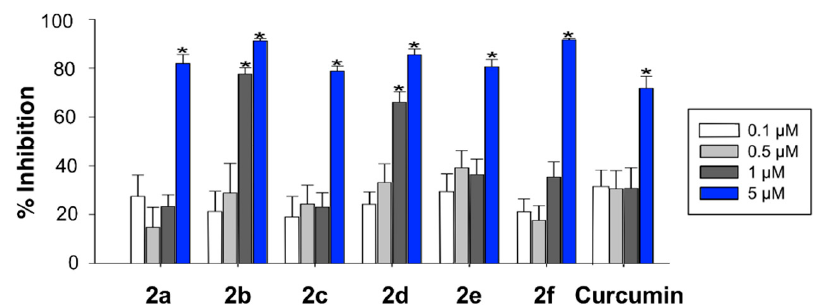
Figure 2. ROS scavenging activity of compounds 2 in HEK293-Tau3R cells, as measured by the inhibition of the ROS-promoted transformation of 2,7-dichlorofluorescin acetate into 2,7-dichlorofluorescein (Newman–Keuls post-hoc test, * p < 0.05 vs. control).